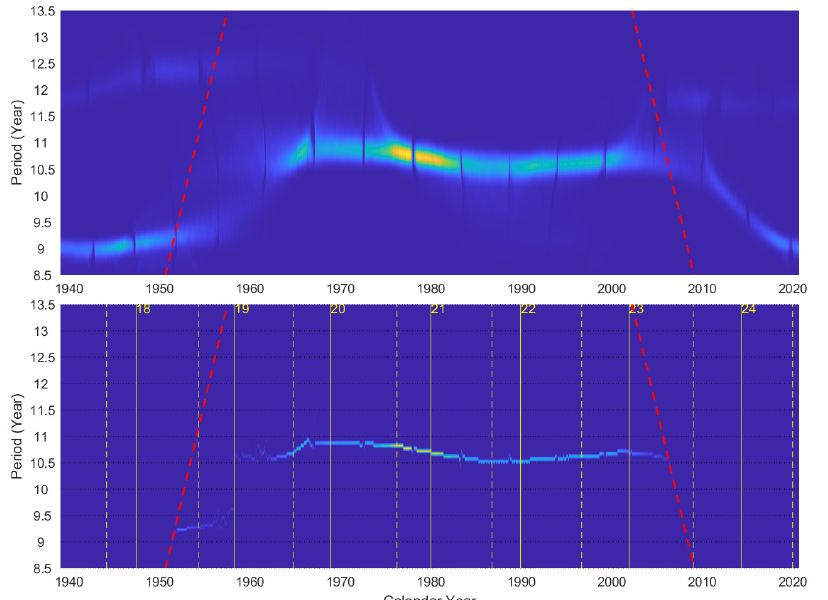
Figure 6. Time–frequency representation of the modified coronal index series with a period between 8.5 and 13.5-yr.The dashed red lines are the cone of influence (COI). ( Upper panel ): the spectrum obtained by ConceFT; ( Lower panel ): the profile of period variation performed by the maximum power at each time point. The vertical solid and dashed yellow lines in the lower panel indicate the maximum and minimum times of normal solar cycles, respectively.